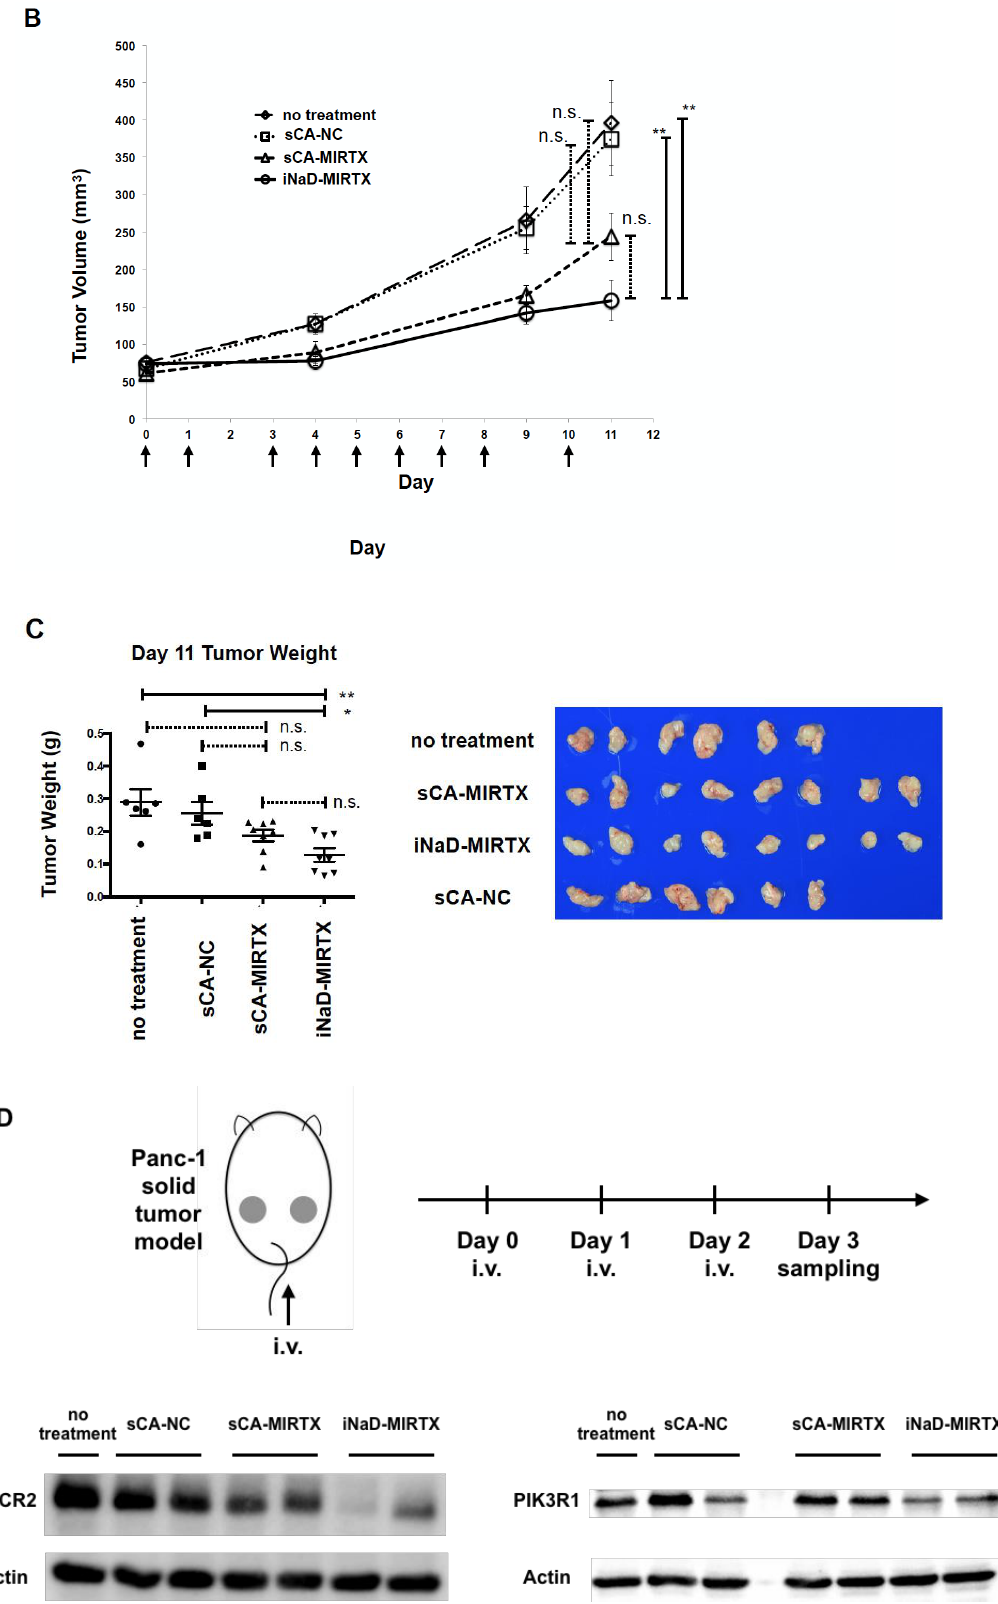
Figure 6. Anti-tumor effect of iNaD-MIRTX. ( A ) sCA-MIRTX and iNaD-MIRTX were prepared for one intravenous injection, followed by measurement of loaded MIRTX, DLS, and zeta potential analysis. The MIRTX loading of sCA-MIRTX was 24 μg , and that of iNaD- MIRTX was 8 μg. ( B ) Therapeutic model of Panc-1 tumors. sCA-MIRTX